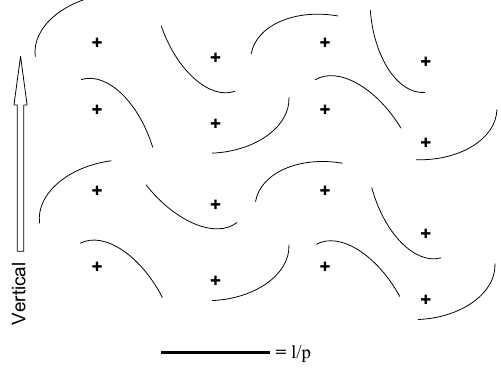
Fig. 11 – Cycloid arcs test-system. Crosses are test-points (n=16). The cycloid arc length is defined as the short line (l/p). The system must be aligned with the sections by the arrow (left side).